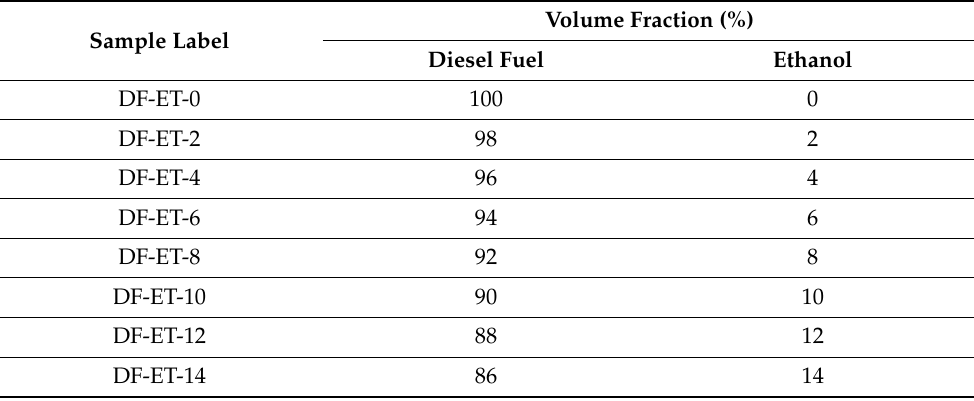
Table 3. Labels of the fuel samples. Sample